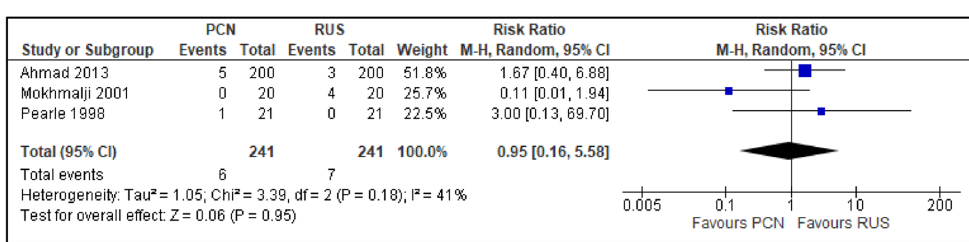
Figure 16. Comparison between PCN and RUS for outcome failure rate.